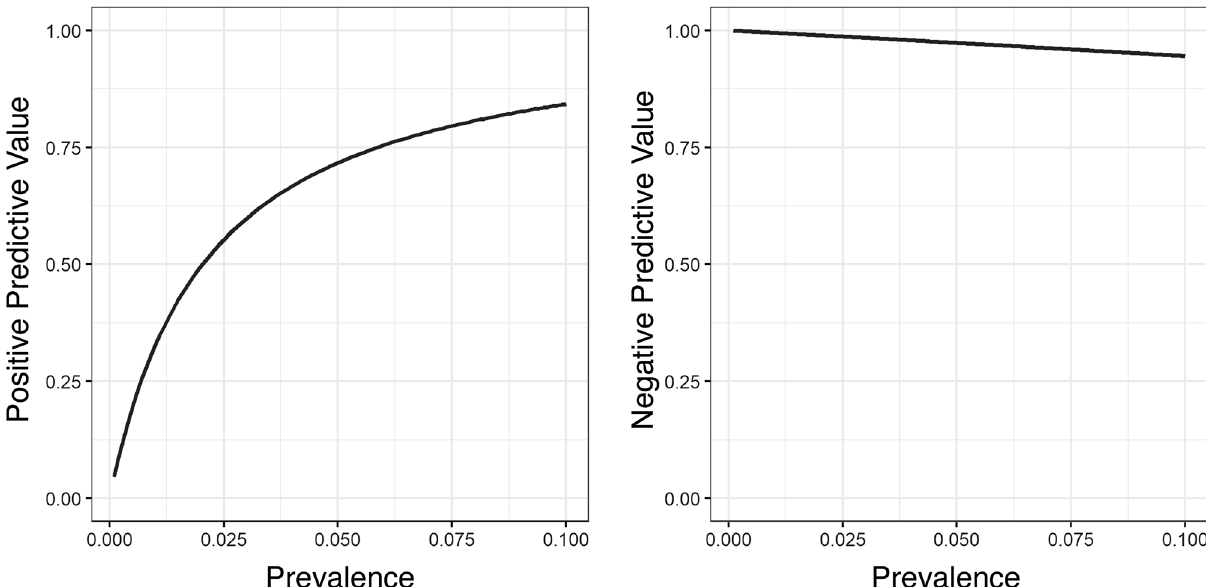
Figure 4. Calculated positive (left) and negative predictive values (right) based on the CareStart performance characteristics and different prevalence estimates of SARS-CoV-2